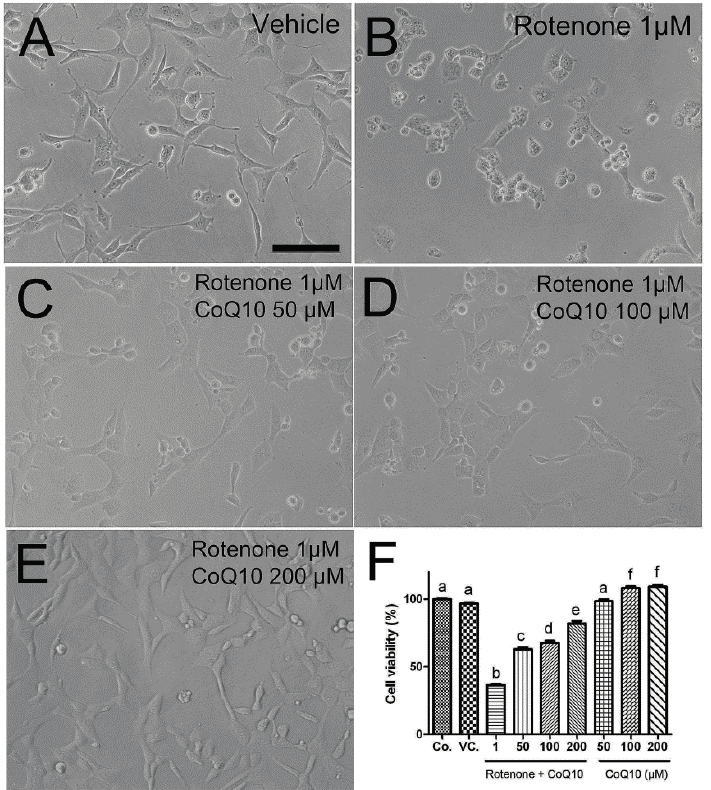
Figure 2. Cell viability in rotenone and CoQ10 incubated HT22 cells. ( A – E ) representative photomicrograms showing cell morphology after 24 of rotenone and/or Co-Q10 treatments; ( F ) a summarizing bar graph showing cell viabilities in naïve control (Co), vehicle control (VC), rotenone (1 µM) + Co-Q10 (50–200 µM) and Co-Q10 (50–200 µM) without rotenone groups. Data were collected from 3 independent experiments and presented as means ± s.d. Groups with same letter labeled on the top indicate no significant difference while groups with different letter suggest a statistical significance when compared among the groups ( p < 0.01). Bar = 200 µm.